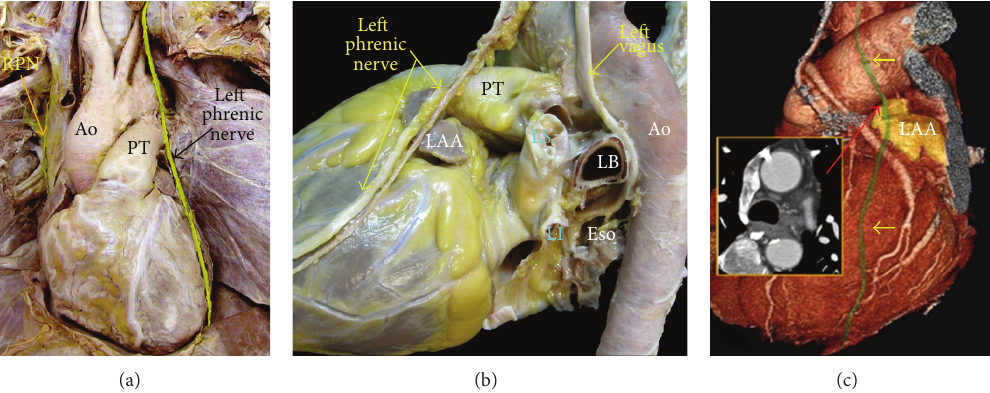
Figure 12: (a) This dissection of a cadaver viewed from the front shows the course of the right and left phrenic nerves. (b) Dissection of the left phrenic nerve, which descends onto the fibrous pericardium anterior and lateral to the aortic arch, alongside the distal part of pulmonary trunk (PT), left atrial appendage (LAA), and the lateral wall of the left ventricle. (c) Left lateral volume rendered CT image of the heart shows the anatomic course of left phrenic neurovascular bundle (shown in green and demarcated by yellow arrows) in relation to the LAA. Corresponding two-dimensional axial CT at the superior margin of the LAA (red arrow) is also shown (inlay images). Neurovascular bundle is usually seen as a single trunk anterior or over the body of LAA. In 23% of individuals, the nerve moves over the neck of LAA. LS = left superior pulmonary vein, Ao = aorta, Eso = esophagus, LB = left bronchus, RPN = right phrenic nerve, and LI = left inferior pulmonary vein.